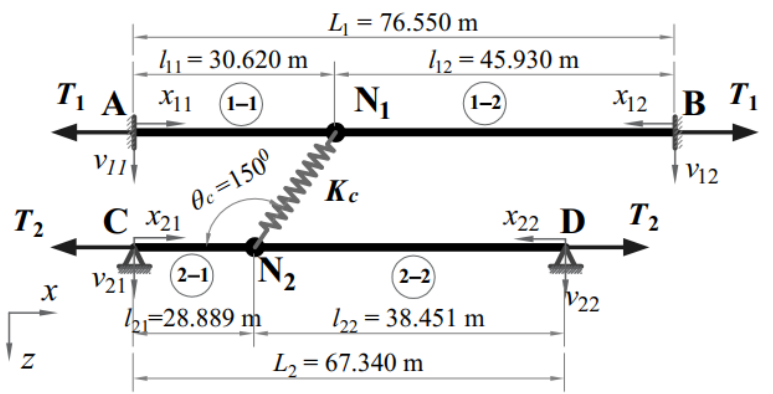
Figure 7. Cable network’s configuration with mixed boundary conditions.